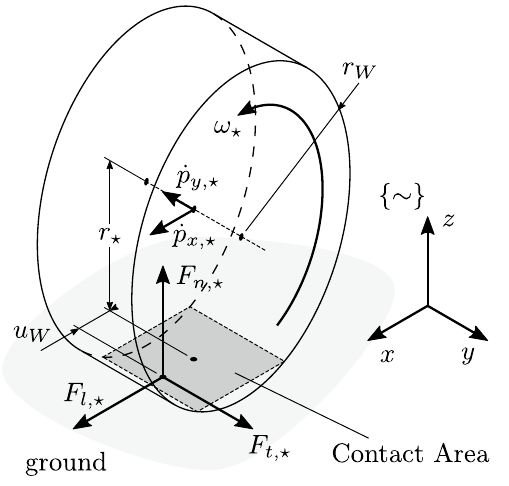
Fig. 13 Tyre-ground contact